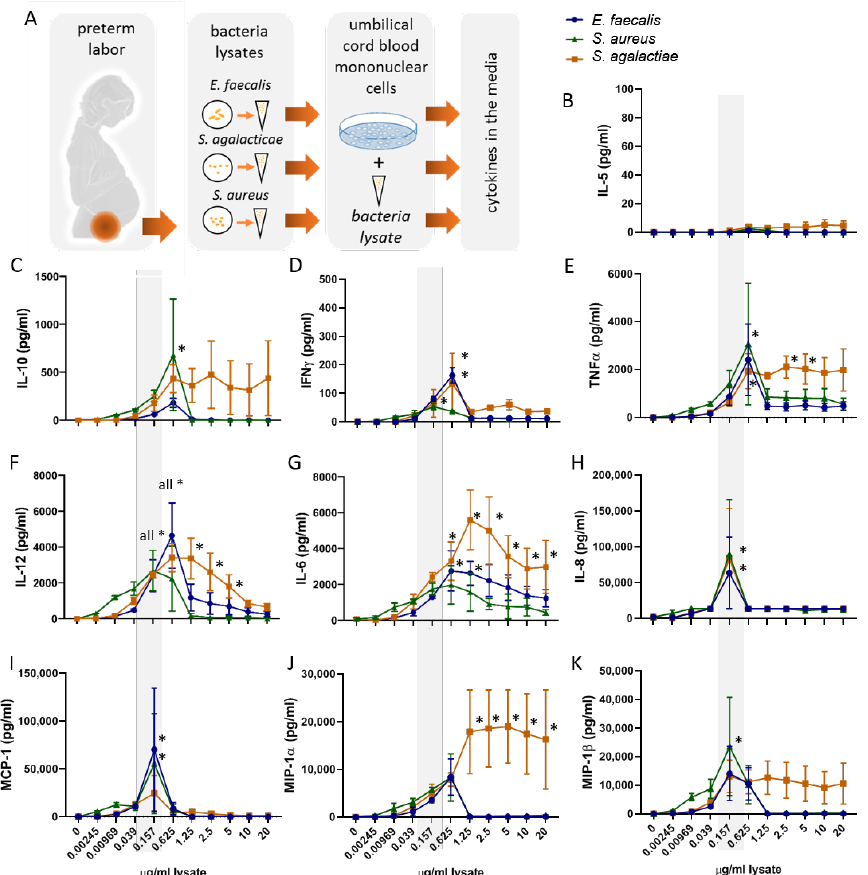
Figure 1. Experimental setup and optimization of umbilical blood mononuclear cells and bacteria lysate stimulation conditions: in our experimental design ( A ) vaginal and cervical bacteria samples from women with impeding preterm labor were collected. E. faecalis , S. agalacticae , and S. aureus were isolated and cultured to produce bacteria lysates. Umbilical blood mononuclear cells (UBMC) from ten term-born infants were stimulated in triplicates for 36 h with or without the respective bacterial lysates. The levels of preselected cytokines and chemokines were determined in the supernatants. ( B – K ) Increasing concentrations of bacteria extract (0.00245–20 µ g/mL lysate) were tested for the induction of ten cytokines (IL-5, IL-10, IFN γ , TNF α , IL-12, IL-6, IL-8, MCP-1, MIP-1 α , und MIP-1 β ), detected using luminex technology. With exception of IL-5 ( B ), the bacteria lysates significantly induced cytokine secretion ( C – K ) (two-way ANOVA p < 0.05). * p < 0.05 in Dunnett’s multiple comparisons test. Concentrations of 0.157 µ g lysate/mL (grey shadow) were selected for further experiments. IL-12 refers to IL12p40/70. The three bacteria are depicted as follows: E. faecalis (blue circles), S. agalacticae (orange squares), and S. aureus (green